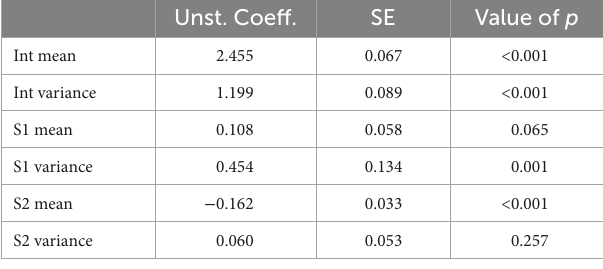
TABLE 3 Unconditional parameter estimates for the piecewise growth model. Unst. Coeff.